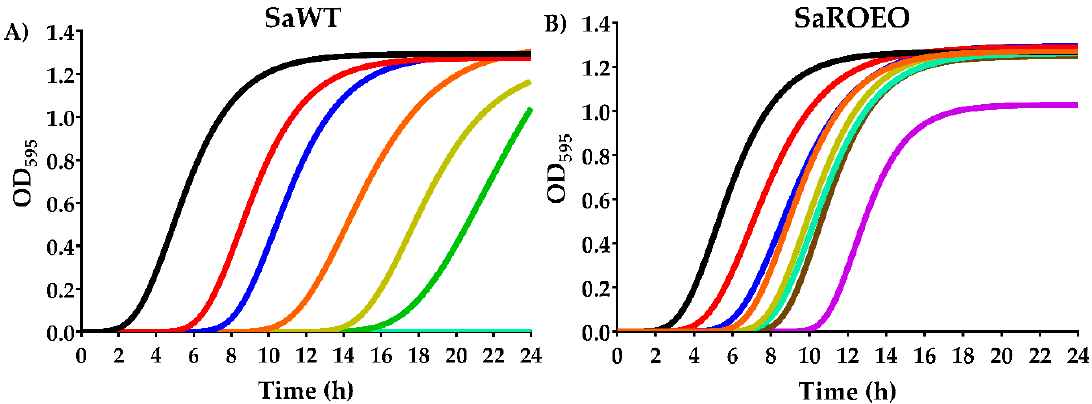
Figure 1. Growth curves of Staphylococcus aureus USA300 ( A ; SaWT) and evolved strain ( B ; SaROEO) in the absence ( ▬ ) and presence of 250 ( ▬ ), 500 ( ▬ ), 750 ( ▬ ), 1000 ( ▬ ), 1250 ( ▬ ), 1500 ( ▬ ), 2000 ( ▬ ), 5000 ( ▬ ) of orange essential oil (OEO), modelled using the modified Gompertz equation (Equation. (1)).